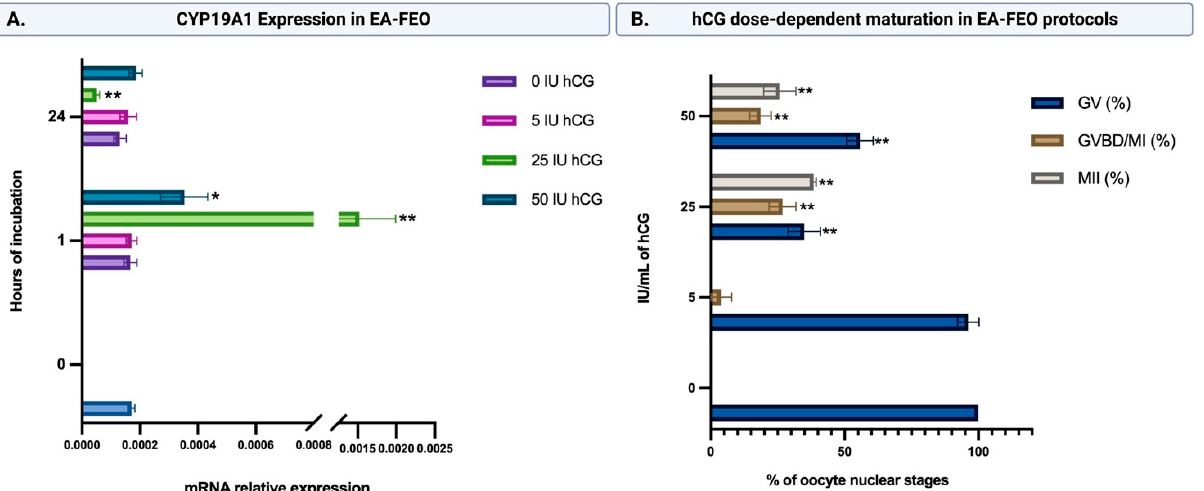
Figure 3. An example of EA incubated as FEO for 24 h on PCL-Pa tt erned electrospun sca ff olds in the absence of any hormonal stimulation.